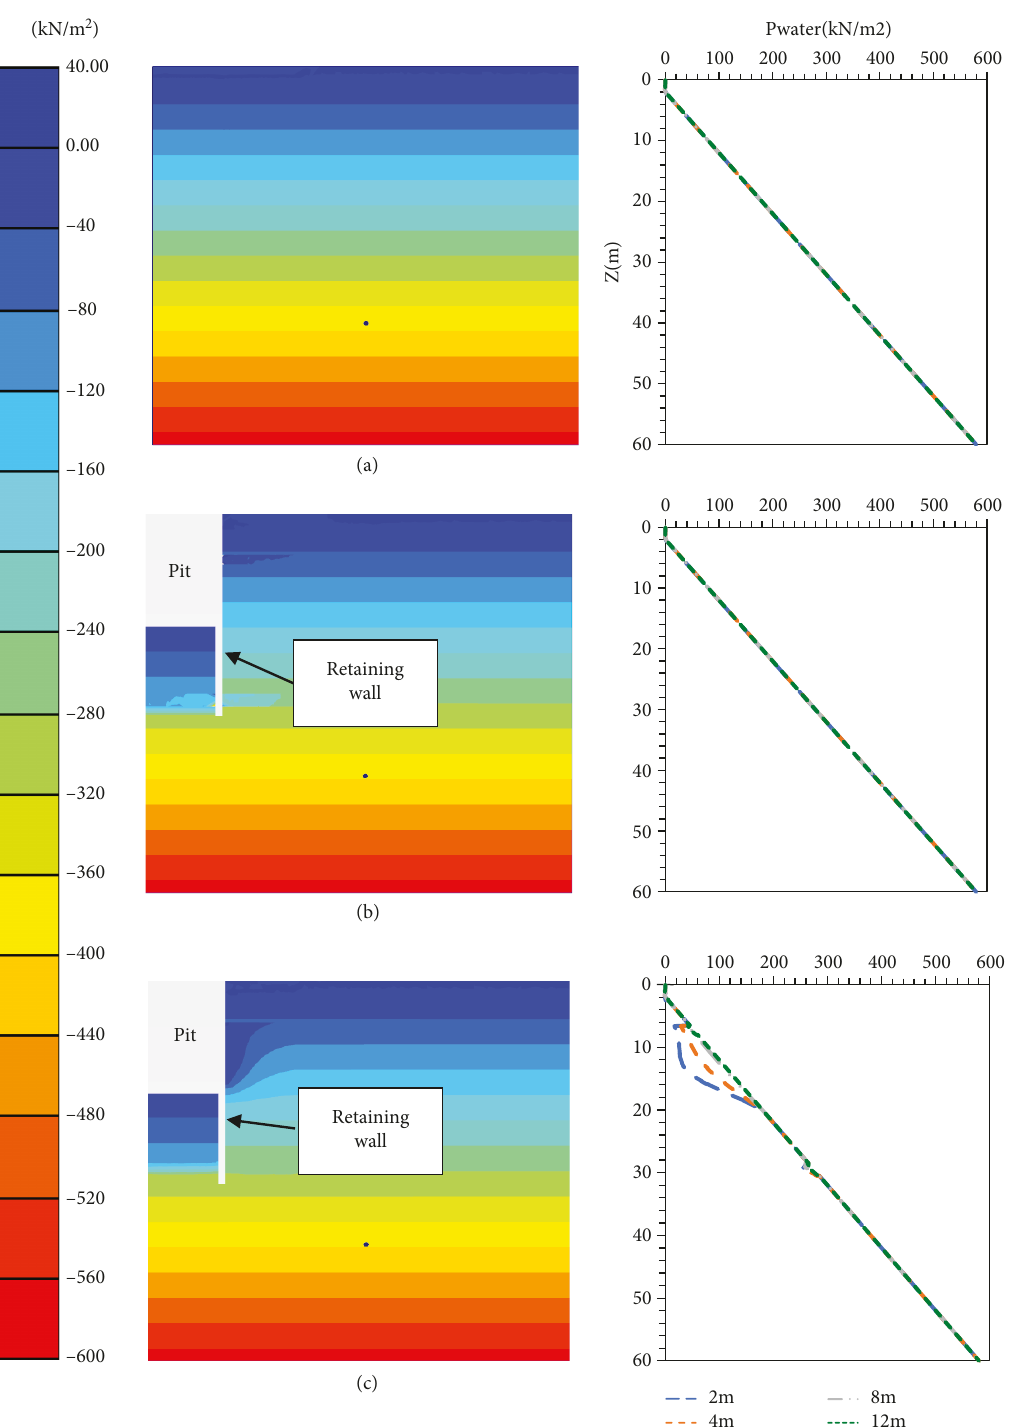
Figure 8: Change of pore pressure distribution at various depths and locations at di ff erent phases of launching of a shield in longitudinal direction. (a) Initial phase. (b) Main excavation. (c) Launching of the shield. Note: legend means points at various distance from the retaining wall and “ - ” in pore pressure distribution contour is positive pore pressure. “ Pwater ” means pore